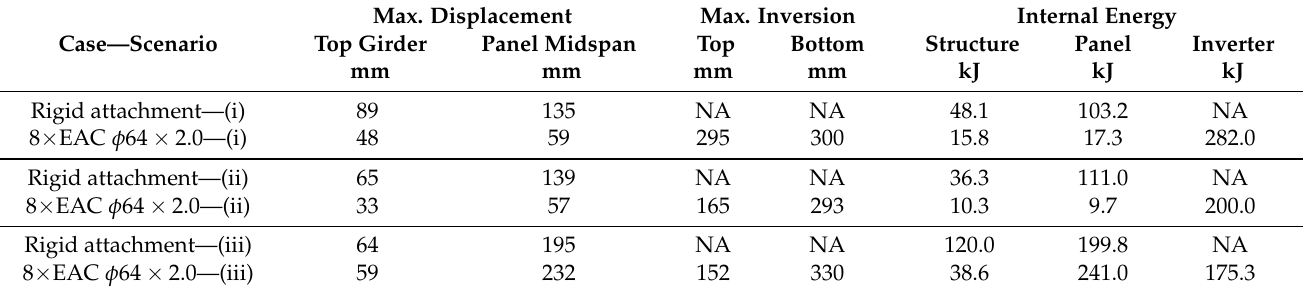
Table 8. Displacements and energies for several blast scenarios: (i) 1,600 kg at 20 m; (ii) 150 kg at 5 m; (iii) 150 kg at 2.5